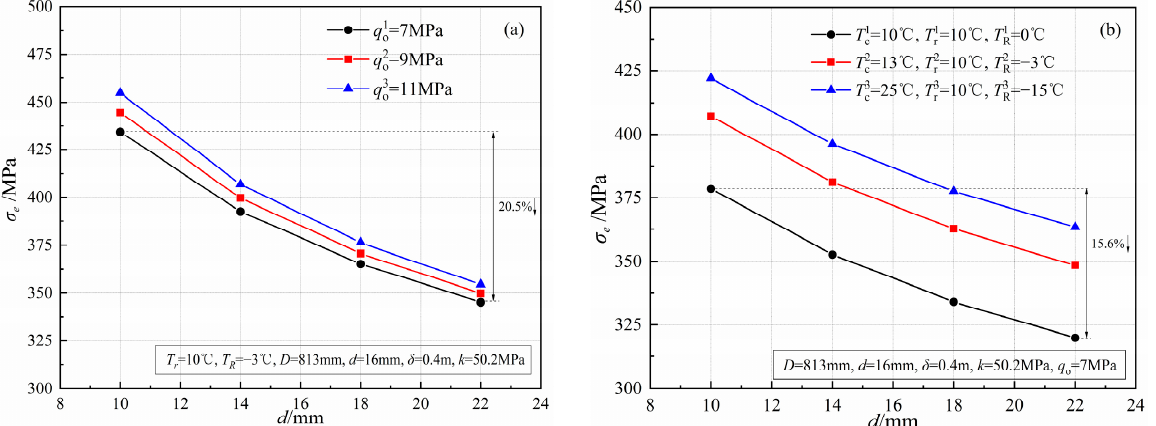
Figure 12. Variations in the equivalent stress with respect to the pipe wall thickness. ( a ) Under different oil pressures; ( b ) Under different temperature differences.